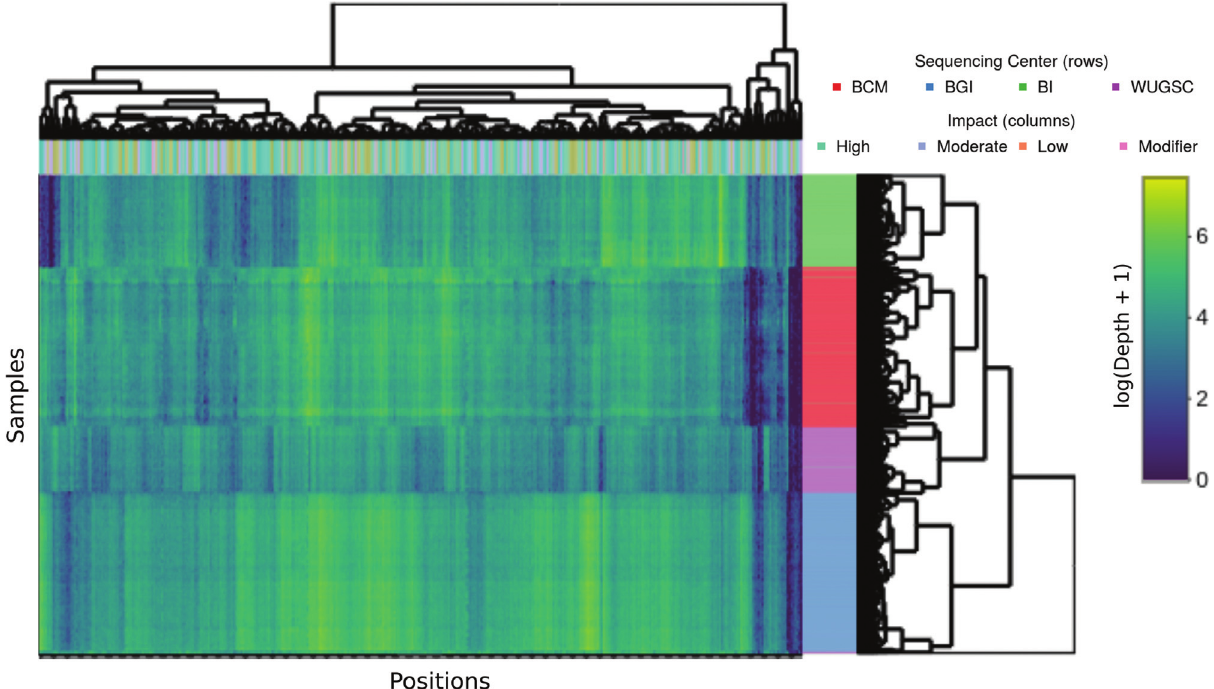
Figure2 -Variationinsequencingdepthacrosssequencingcentersandcodingimpact.Heatmapshowingvariationindepthacrosssequencingcentersfor the 450 variants with higher variance across samples. Each row represents a sample from one of the sequencing centers (BCM - Baylor College of Medi- cine, BI - Broad Institute, BGI, and WUGC - Washington University Genome Center). 96.9% of samples are correctly assigned to their sequencing cen- terswhenconsideringfiveclusterstothedendrogrambranches.Thecolumnsrepresenteachoneofthevariants,withtheirimpactclassifiedashigh,mod- erate, low, or modifier, which is an indicator that the coding impact does not influence the depth of coverage (p > 0.05 for each pair comparisons). An interactive version of this figure is available as File